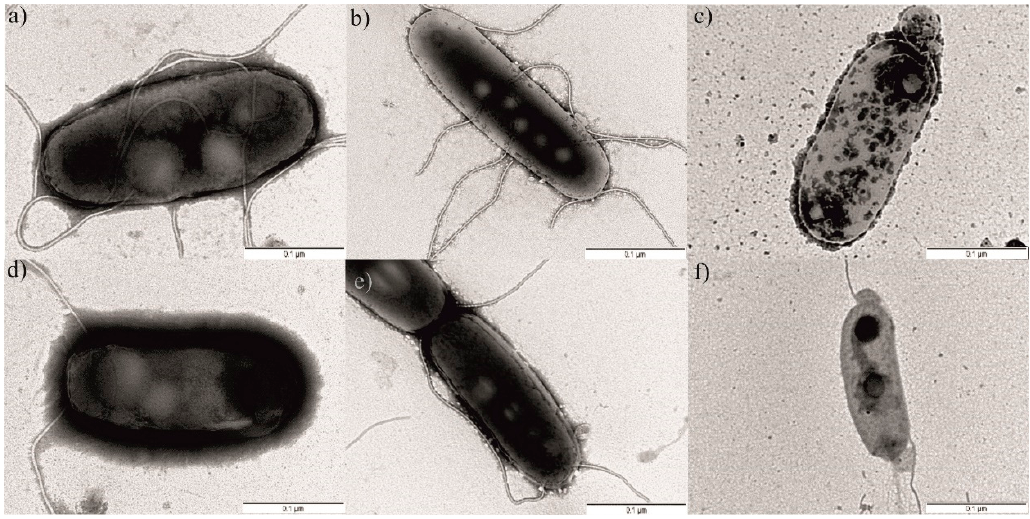
Figure 8. TEM images of L. pneumophila isolated from the ferry: untreated ( a ), grown in A. castel- lanii ( b), and pasteurized at 53 °C for 10 min ( c ); L. pneumophila isolated from the hotel: untreated ◦ C for 10 min ( c ); L. pneumophila isolated from the hotel: untreated ( d ), ( d) , grown in A. castellanii ( e ), pasteurized at 53 °C for 10 min ( f ). ( b ), and pasteurized at 53 grown in A. castellanii ( e ), pasteurized at 53 ◦ C for 10 min ( f